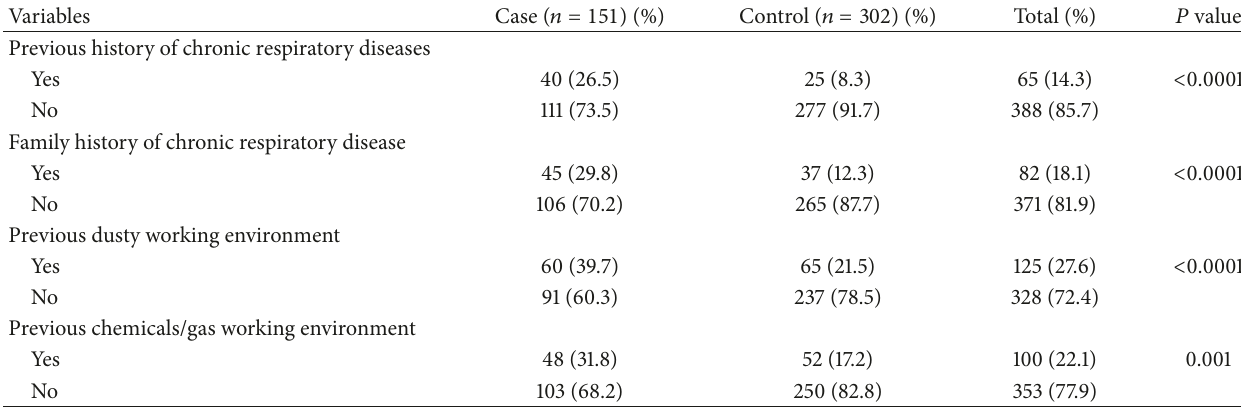
Table 2: Distribution of previous and family history of CRDs and past dust and chemicals/gas working environment of participants in pharmaceutical factories in Addis Ababa, Ethiopia, May 2017.